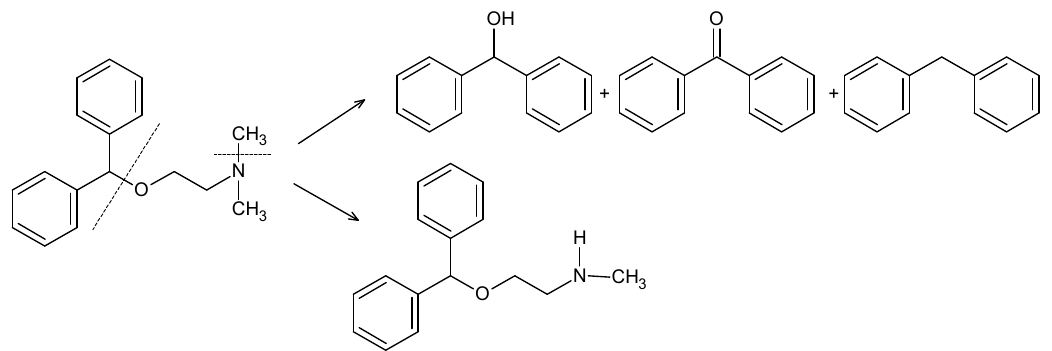
Figure 8. Hypothetical degradation of diphenhydramine (DIPH) under thermolytic and photolytic conditions.